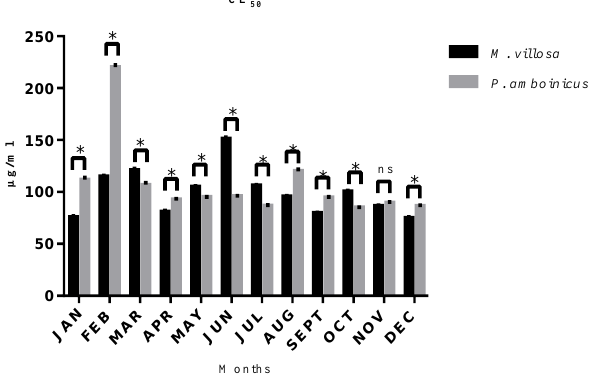
Figure 4. CEE of M. villosa and P. amboinicus EC 50 in µg/mL and their statistical comparations throughout 12 months. ns = nonsignificant. * statistical difference